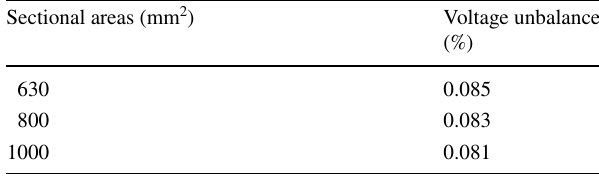
Table 4 Voltage unbalance in different cross-sectional areas Sectional areas (mm 2 )